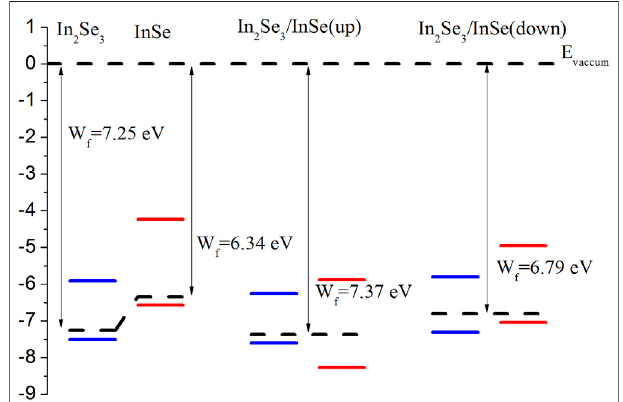
FIGURE 5 | Band alignments of monolayer In 2 Se 3 , monolayer InSe, and In 2 Se 3 /InSe (up) and In 2 Se 3 /InSe (down) heterostructures. The horizontal dashed lines represent the Fermi level.